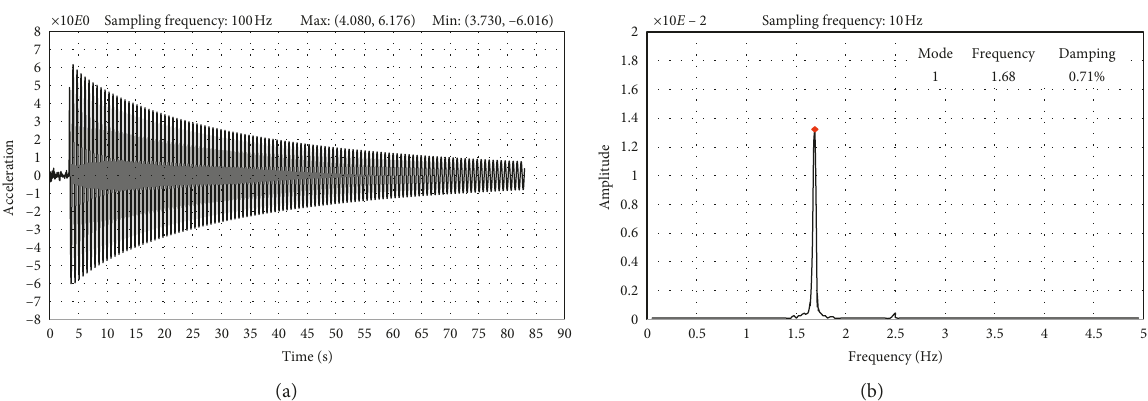
Figure 22: Monitoring results with the particle damper (3 steel balls in container). (a) Acceleration-time history curve of the frame. (b) Identified frequency and damping